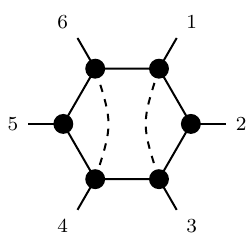
Figure 2 . Chiral